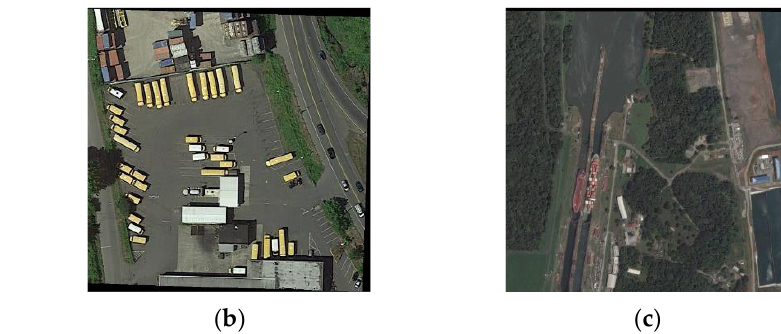
Figure 1. The difficulties of object detection in RSIs. ( a ) Represents the small size of remote sensing objects; ( b ) represents the interference of RSIs by similar objects and other external factors; ( c ) represents the side-by-side placement of remote sensing objects.